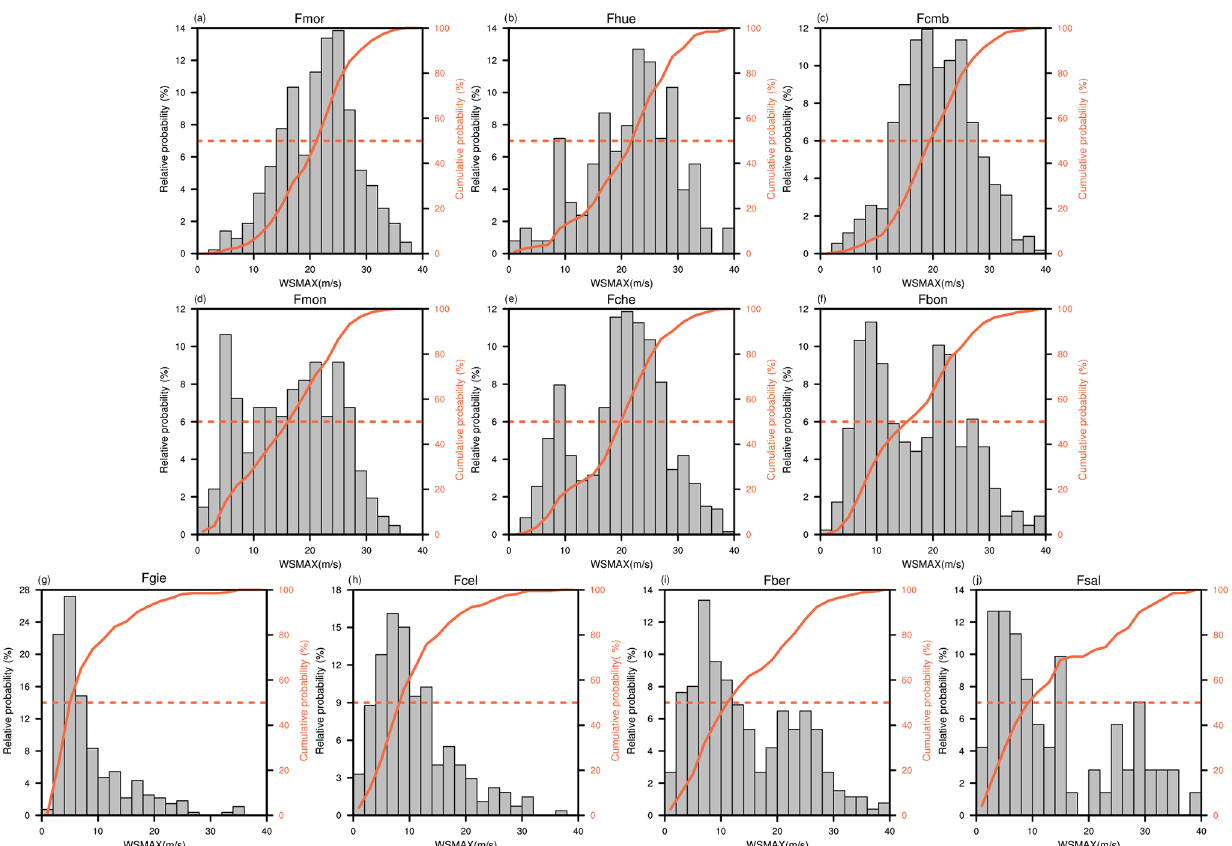
Figure 6. The relative probability and cumulative probability of blowing snow occurrences, plotted with the maximum wind speed. The histogram is the relative probability and the orange solid curve is the cumulative probability, respectively. The orange dash line is the 50% cumulative